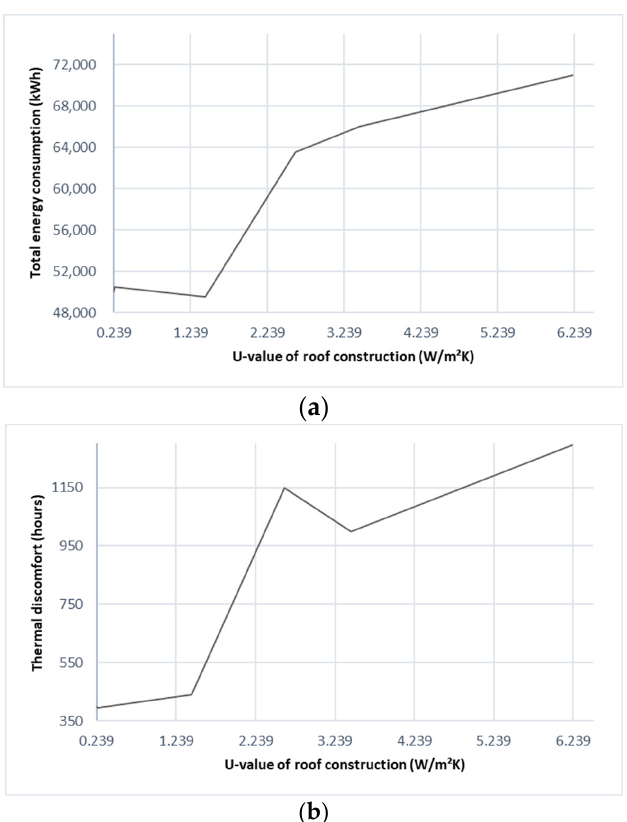
Figure 7. The effect of U-Value of external wall construction on ( a ) energy consumption. ( b ) Stu- dents’ thermal discomfort hours